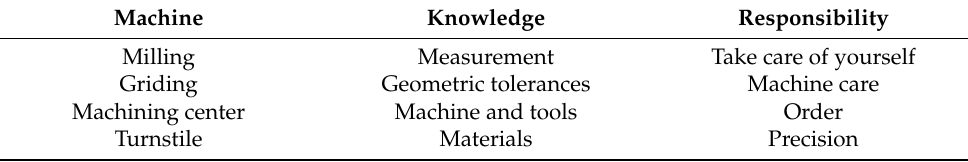
Table 2. Some functions and activities considered for the production system. Function Activity Function Production control Plan the quantity of parts to be